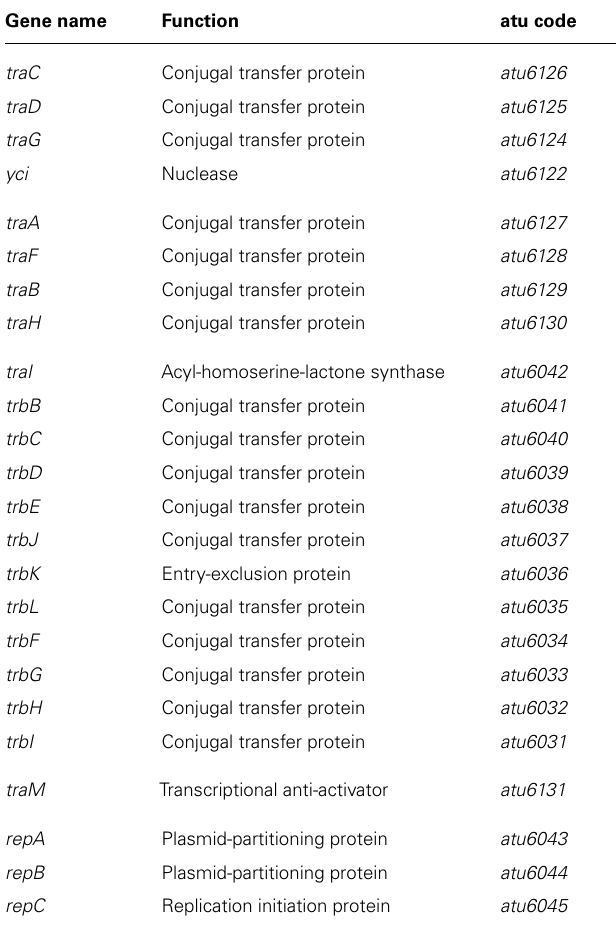
Table 1 | List of QS-regulated genes in nopaline- and octopine-typeTi plasmids (adapted from Cho andWinans,